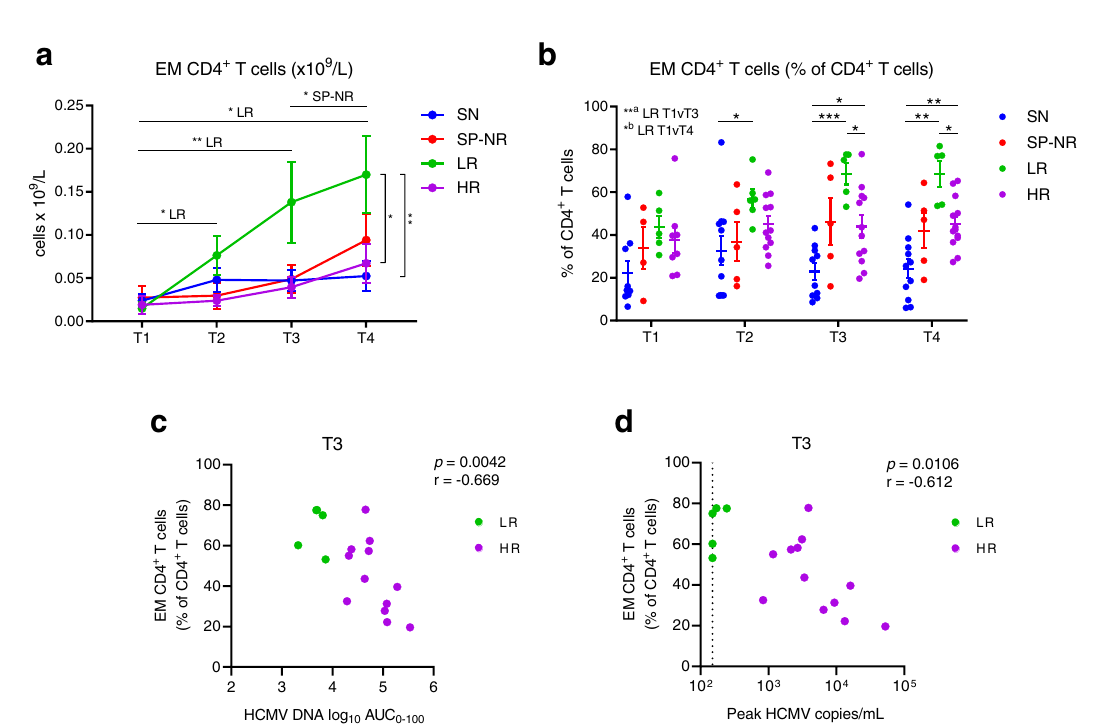
Fig. 6 Expansion of effector-memory CD4 + T cells in HSCT recipients with low-level HCMV reactivation. a Absolute counts (x10 9 /L blood) of